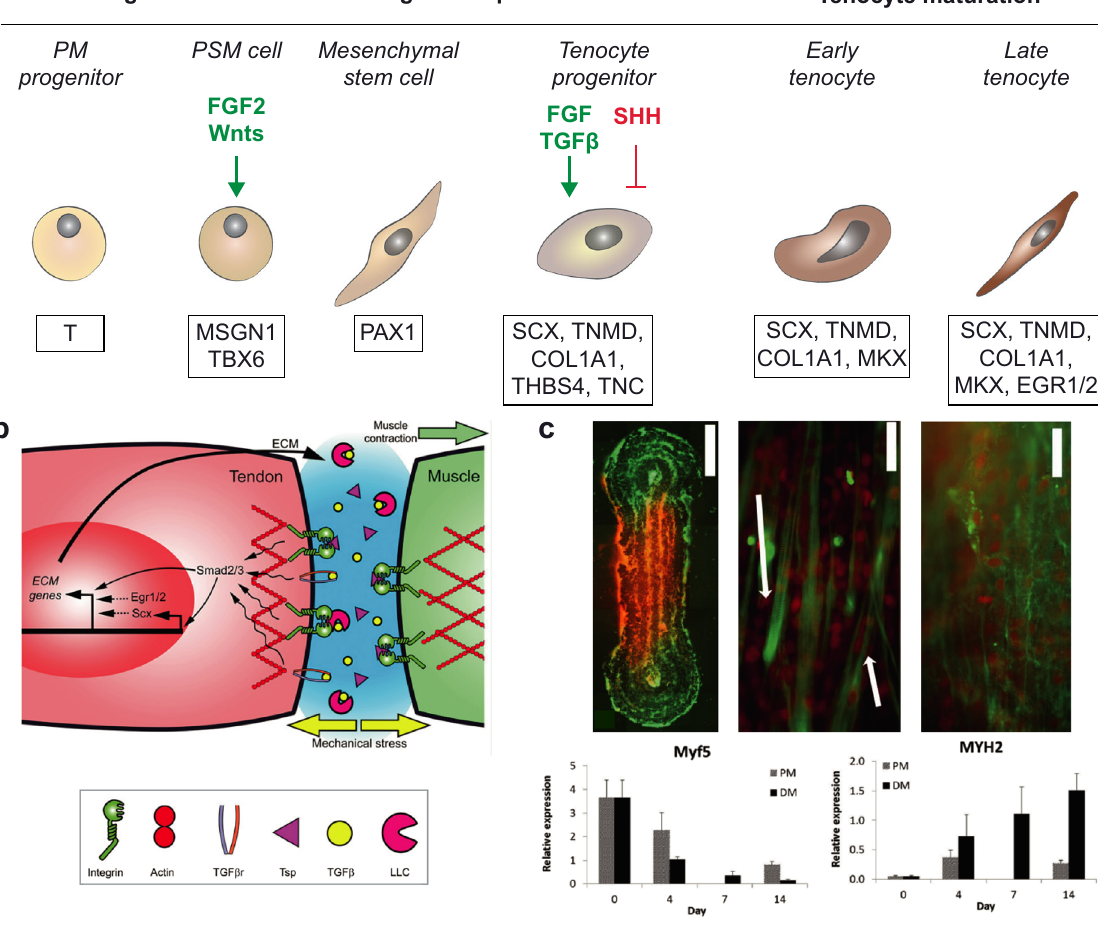
Fig. 8 Tenocyte development and co-culture with skeletal muscle cells: in fl uence on myogenesis. a Representation of the differentiation process of tenocytes starting from the paraxial mesoderm (PM) progenitors. Marker genes are shown in the bottom boxes, while the main signaling molecules are indicated in green if acting as pro-differentiative actors, in red if they inhibit the differentiation process. PSM presomitic mesoderm. b Scheme of the myotendinous junction formation. Image adapted and reproduced with permission from 196 . c Top left: 3D printed co-culture of myoblasts (red) and tenocytes (green) just after printing. Scale bar: 2 mm. Top middle: co-culture differentiated for seven days and stained for myosin heavy chain (green) and nuclei (red). Arrows indicate striated and multinucleated myo fi bers. Top right: focus on the tenocytes in the co-culture stained for type I collagen. Scale bar: 50 µm. Bottom: gene analysis expression of muscle and tendon monoculture in proliferation medium (PM = gray bars) or differentiation medium (DM = black bars). Relative expression is shown as mean ± standard error of the mean (SEM). Images adapted and reproduced with permission from 198